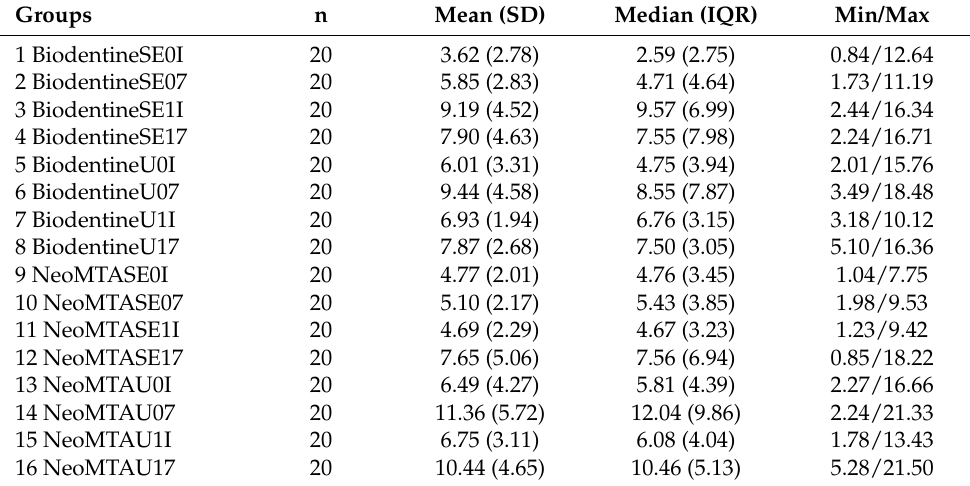
Table 3. Global results of the tested groups regarding SBS values (MPa).